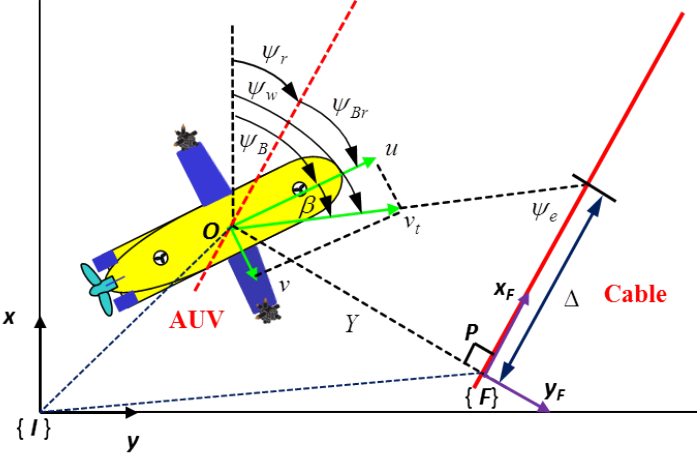
Figure 5. Let the position and course angle of the under-actuated AUV be denoted by O = ( x , y , ψ w ) (cid:62) in the inertial frame { I } , and let the position and orientation of the projection point of the AUV on the path be denoted by P = ( x r , y r , ψ r ) (cid:62) in the inertial frame { I } . The side-slip angle β = arctan ( v In the Serret–Frenet frame { F } with the origin at P , the LOS guidance angle is defined as arctan ( − Y ∆ ) , where Y is the horizontal offset of the AUV relative to the cable, and the look ahead distance ∆ is constant. The choice of ∆ is instrumental to shape the AUV moving towards the straight-line